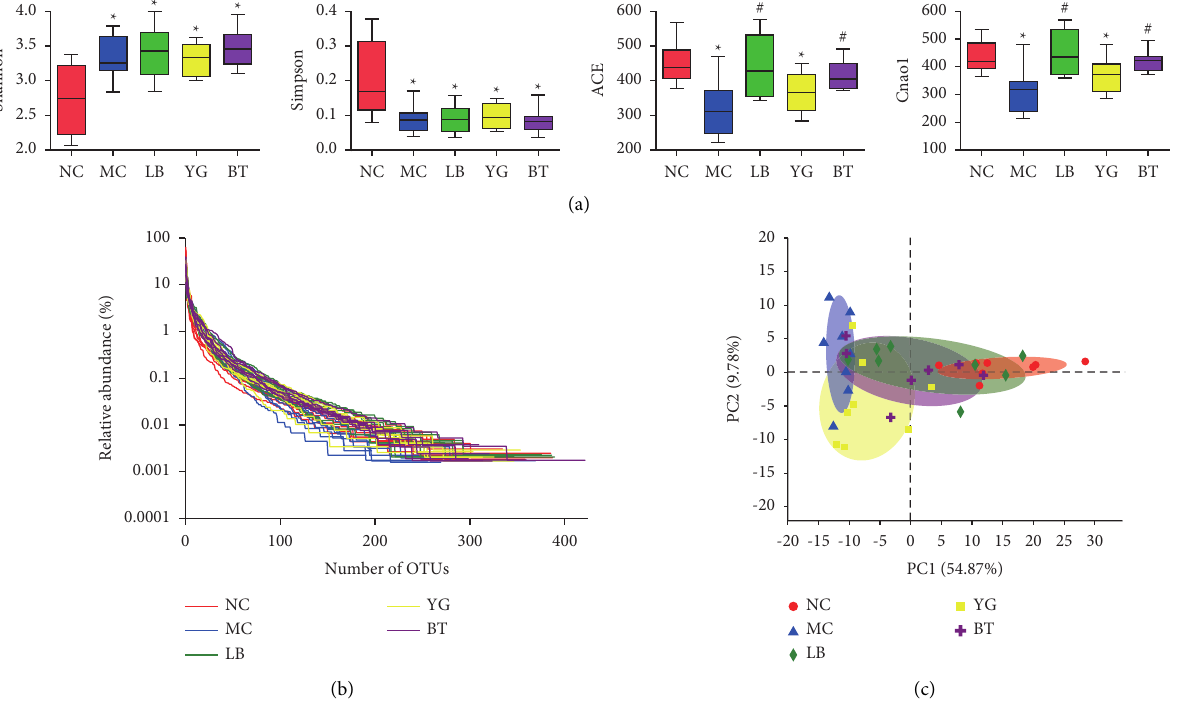
Figure 2: Changes in the gut microbiota diversity of different groups. Alpha diversity indices including Shannon, Simpson, ACE, and Chao1 indices (a); (b) rank-abundance curve; (c) PCA score plot of the microbiota in the different groups. NC, normal group; MC, model group; LB, Lacidophilin tablet group; YG, yogurt group; BT, bifid triple viable capsule group. Values are represented as the mean ± SD. ∗ p < 0 . 05 compared with the normal group, and # p < 0 . 05 compared with the model